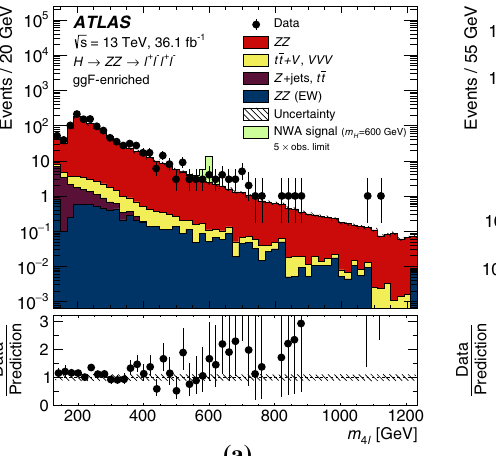
responding to five times the observed limit given in Sect. 8.3.1. The error bars on the data points indicate the statistical uncertainty, while the systematic uncertainty in the prediction is shown by the hatched band. The lower panels show the ratio of data to prediction